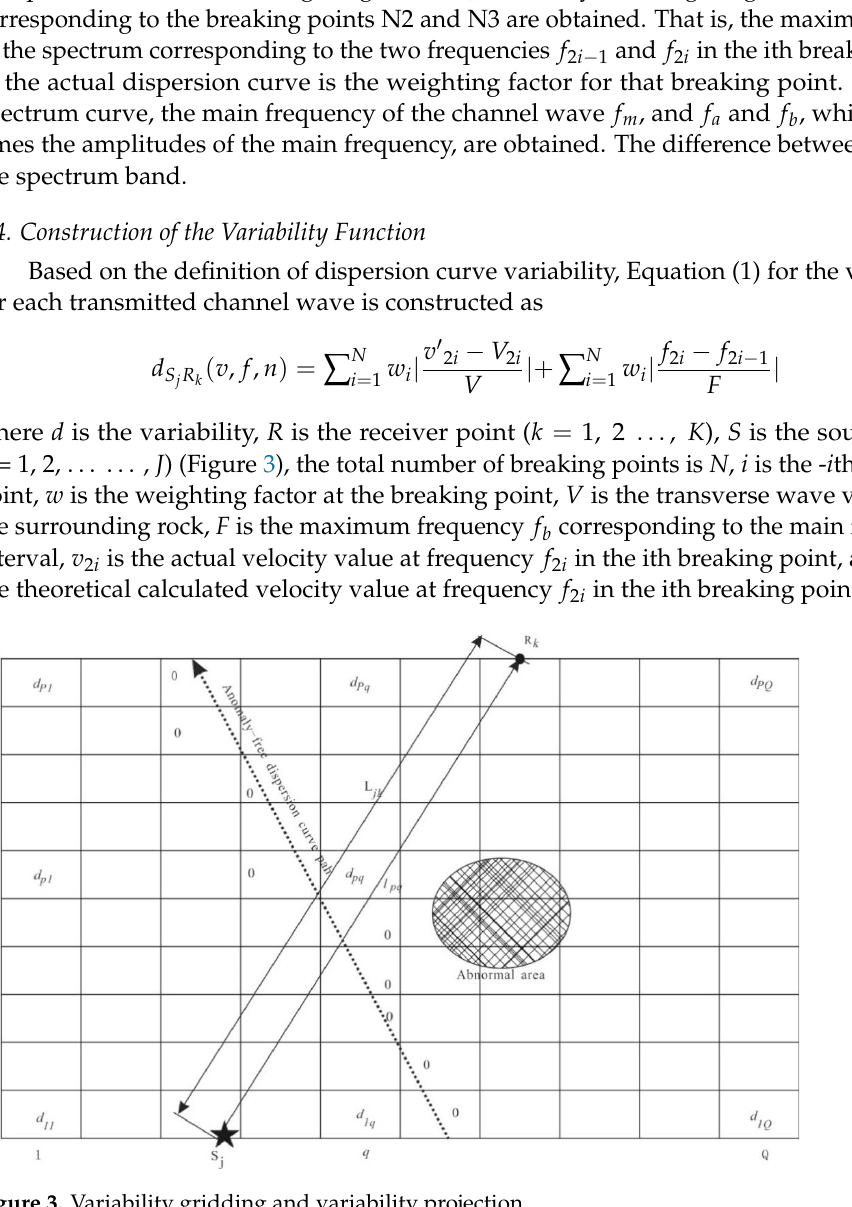
Figure 3. Variability gridding and variability projection. The first term to the right of the equal sign in Equation (1) indicates the magni- tude of the contribution of velocity (time) intermittency to the variability value, and the second term indicates the magnitude of the frequency intermittency contribution to the variability